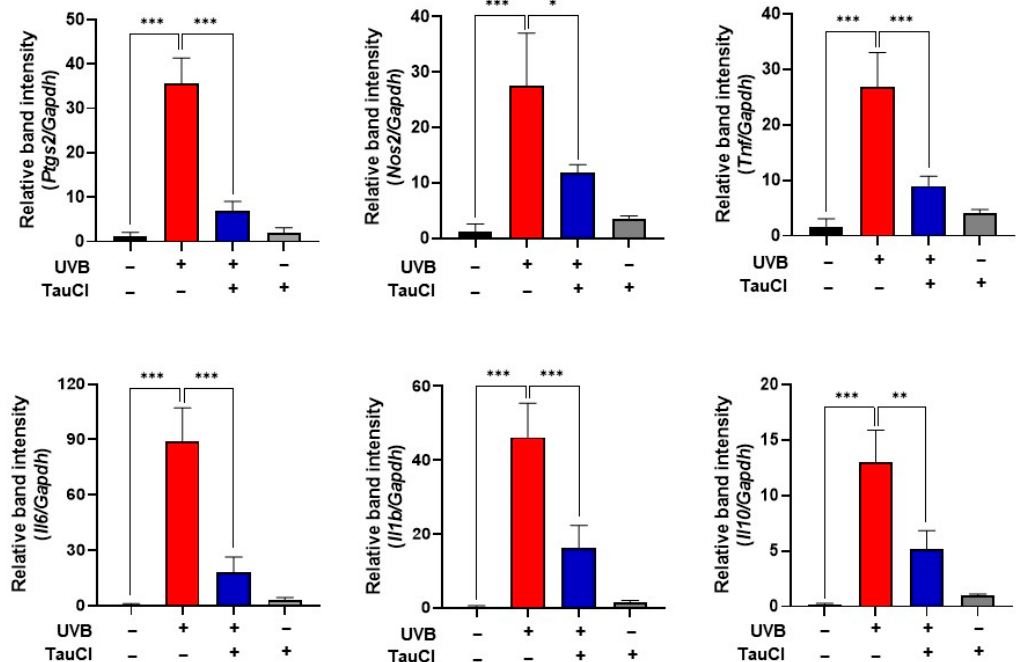
Figure 3. TauCl application inhibited UVB-induced expression of pro-inflammatory cytokines and enzymes in mouse skin. qPCR analysis of mRNA transcripts for pro-inflammatory cytokines ( Tnf, Il6, Il1b, Il10 ) and enzymes ( Ptgs2, Nos2 ). The treatment conditions and other experimental details are as described in Materials and Methods. Results are analyzed by one-way ANOVA and expressed as means ± SD ( n = 3 per group). * , ** , *** Significantly different between groups compared (* p < 0.05; ** p < 0.01; *** p < 0.001).